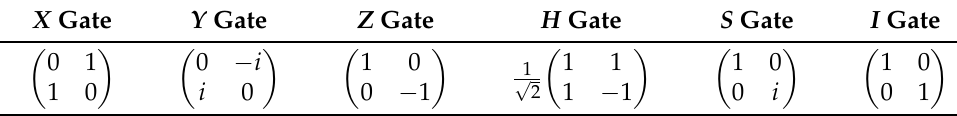
Table 4. Quantum gates for a single qubit.